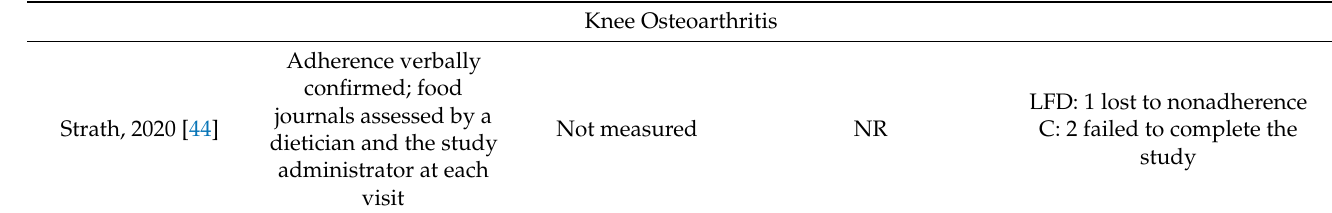
Table 2. Cont. Knee